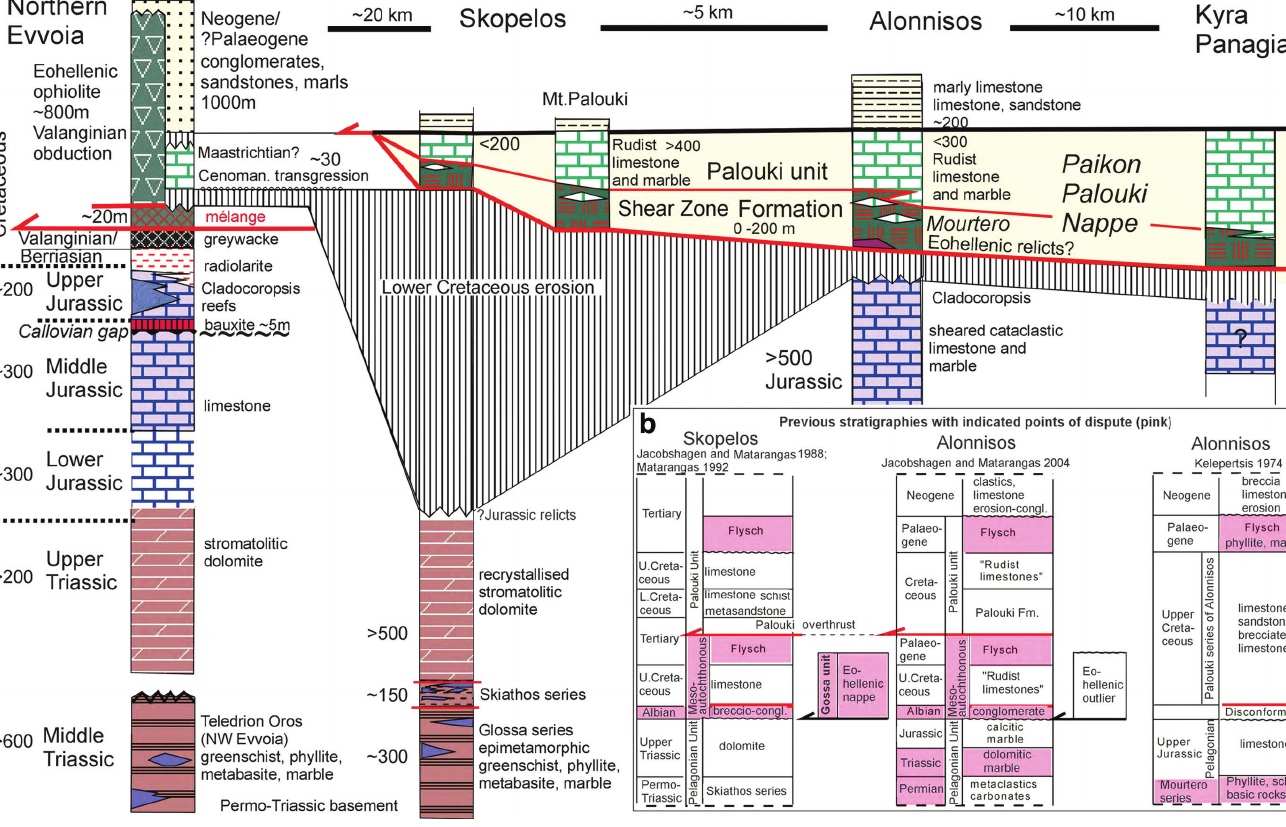
Tectono-stratigraphic correlations in Pelagonian–Vardar zones